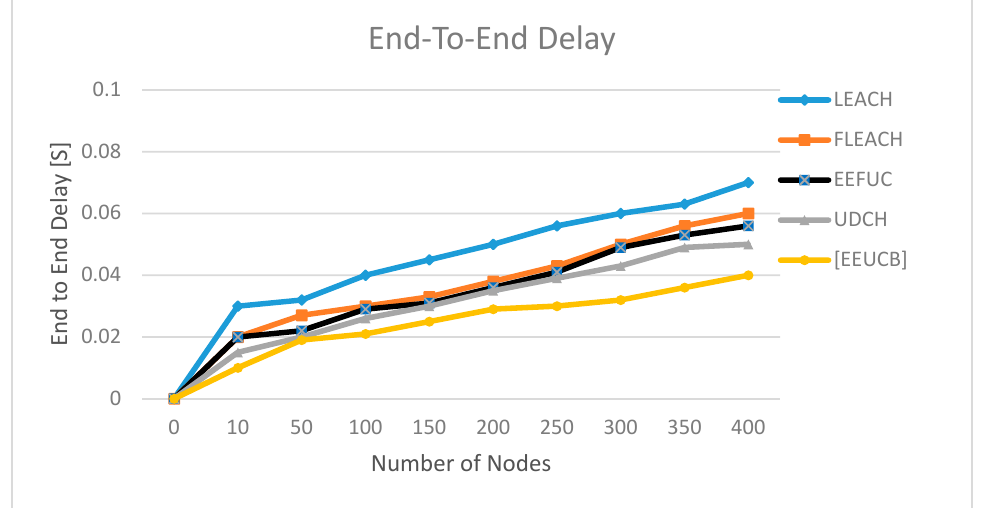
Figure 14. The end-to-end Delay.